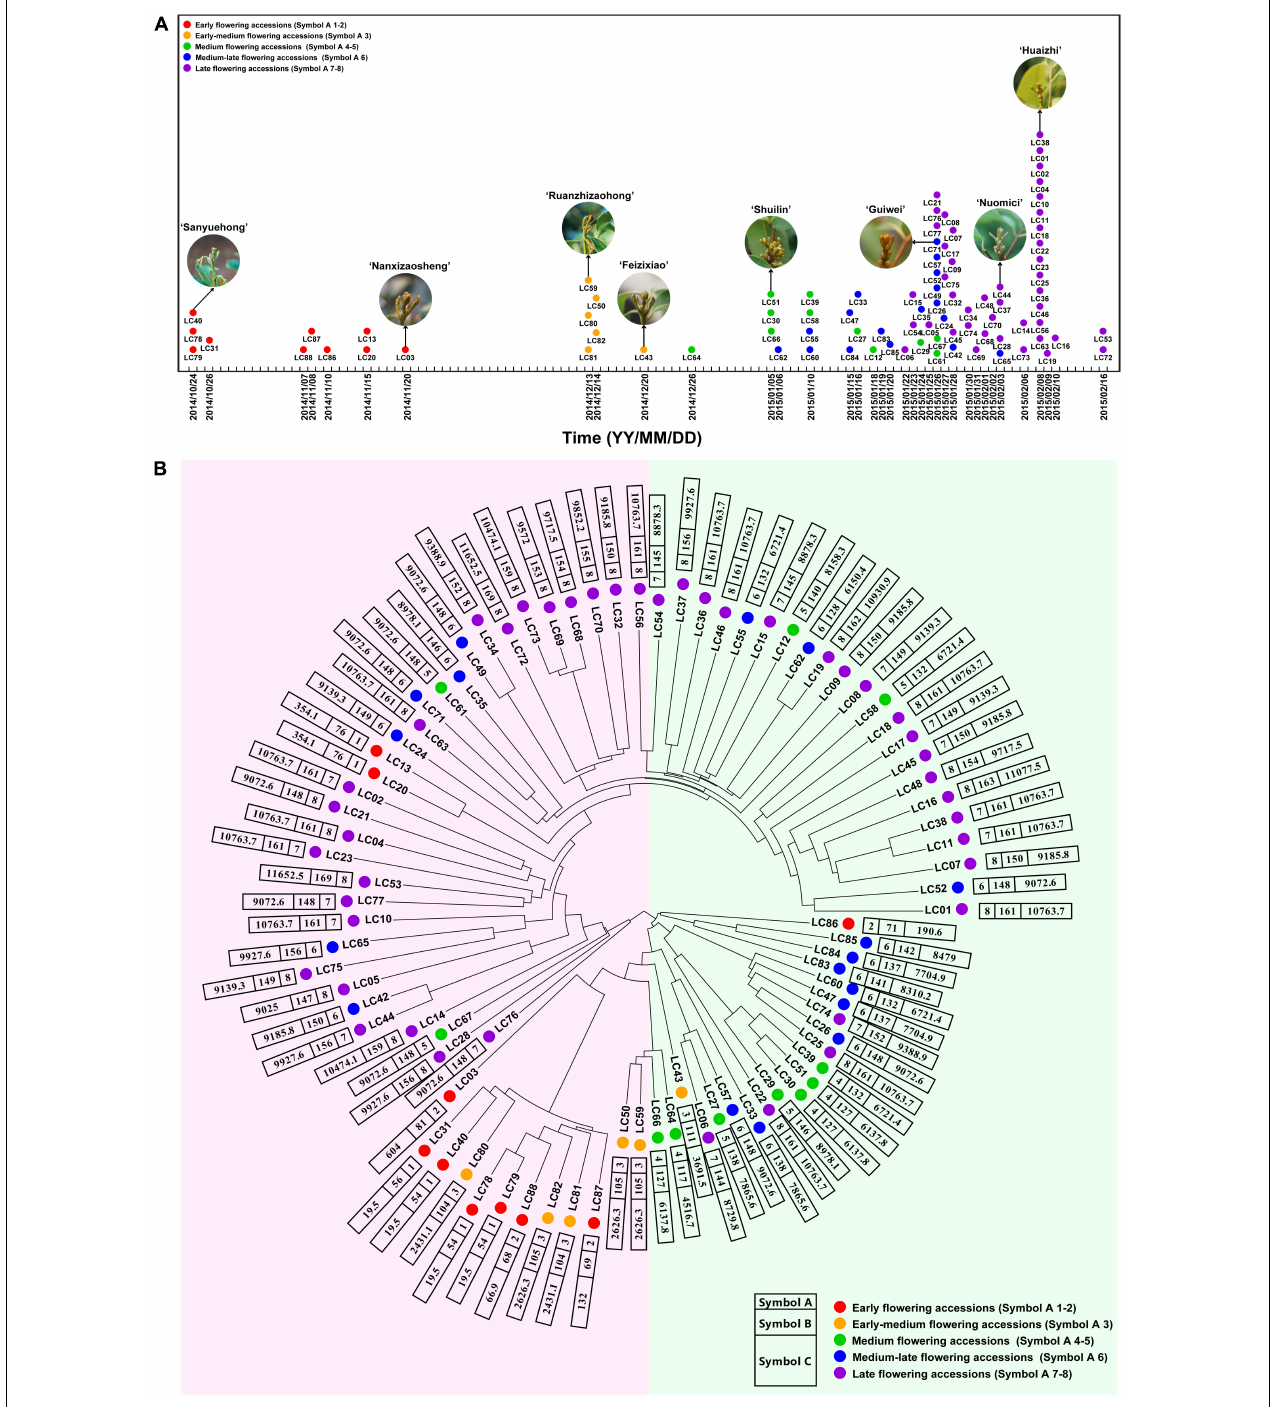
FIGURE 1 | Schematic diagram of flowering time and phylogenetic tree of litchi accessions based on SNP data. (A) Schematic diagram of flowering time of the 87 litchi accessions. (B) Phylogenetic tree of the accessions based on SNP data. Symbol A, flowering phenotype based on the time of panicle primordium (“whitish millet”) emergence. Symbol 1–2, 3, 4–5, 6, 7–8 indicate early, early-medium, medium, medium-late, and late flowering accessions, respectively, and are signed by red, orange, green, blue, and purple dots. Symbol B, flowering phenotype based on days required for floral induction. Symbol C, flowering phenotype based on chilling accumulation. Detailed information of the accessions is listed in Supplementary Table 1